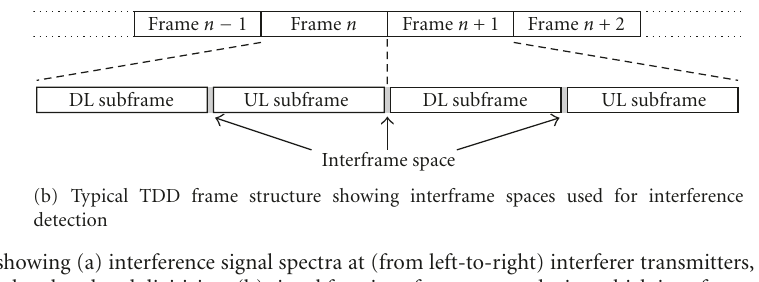
Figure 1: System model, showing (a) interference signal spectra at (from left-to-right) interferer transmitters, receiver front end, and after filtering, downcoversion to baseband and digitizing; (b) signal free, interframe spaces during which interference is